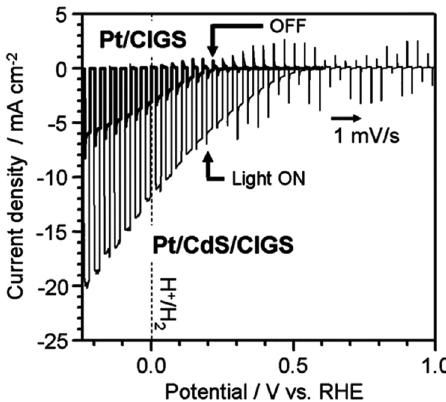
Figure 8: Current density – potential ( J – V ) plots of Pt/CdS/Cu ( In,Ga ) Se 2 ( Pt/CdS/CIGS ) and Pt/Cu ( In,Ga ) Se 2 ( Pt/CIGS ) photocathodes in 0.1 M Na 2 SO 4 aqueous solution ( pH = 9.5 ) under intermittent irra - diation of 350 – 800 nm light. Reprinted with permission from ref. [ 21 ] . ©2010 Elsevier Science